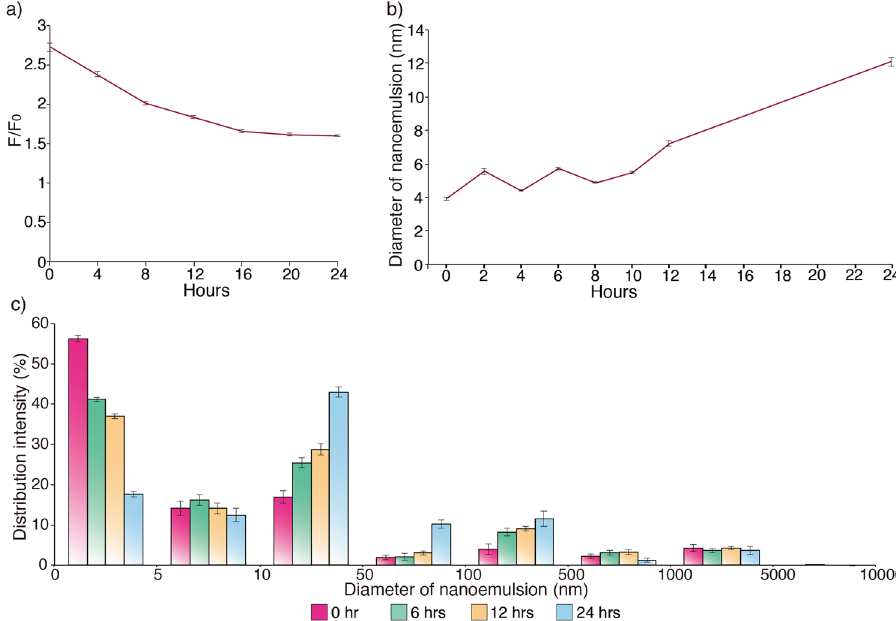
Figure 3. ( a ) Content of NO in the NE for 24 hours. The fluorescence intensity of NO slowly decreased over 24 h of storage. (F 0 : Fluorescence intensity of the NE without NO). ( b ) Changes in diameter of the NE for 24 hours. The diameter of NE started to increase from 10 h after fabrication, resulting in 3-fold increase after 24 h of storage. ( c ) Distribution intensity in the size of NE over the course of storage